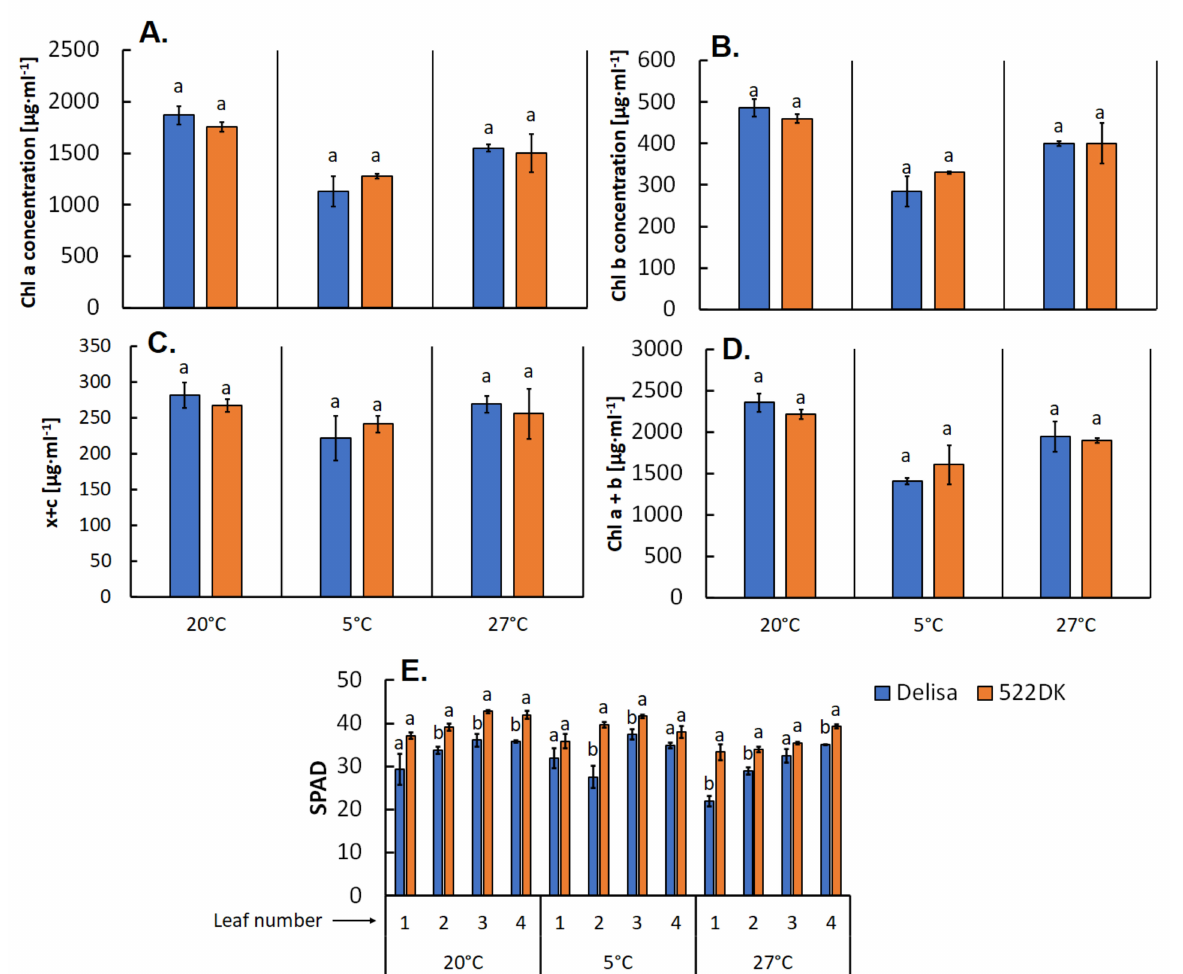
Figure 2. Concentration of chlorophyll (Chl) a ( A ), chlorophyll b ( B ), xantophylls and carotenoids (x + c) ( C ), and total chlorophyll ( a + b ) ( D ) in a suspension of chloroplasts from the barley wild-type Delisa and its 522DK mutant. ( E ) The greenness intensity [SPAD units] of 1st–4th leaf of Delisa and its mutant 522DK. Plants had been cultivated at 20 ◦ C and acclimated at 5 ◦ C and 27 ◦ C. Mean values ( ± SE) marked with the same letters (separately for plant growth temperature) did not significantly differ according to Student’s t -test ( p ≤